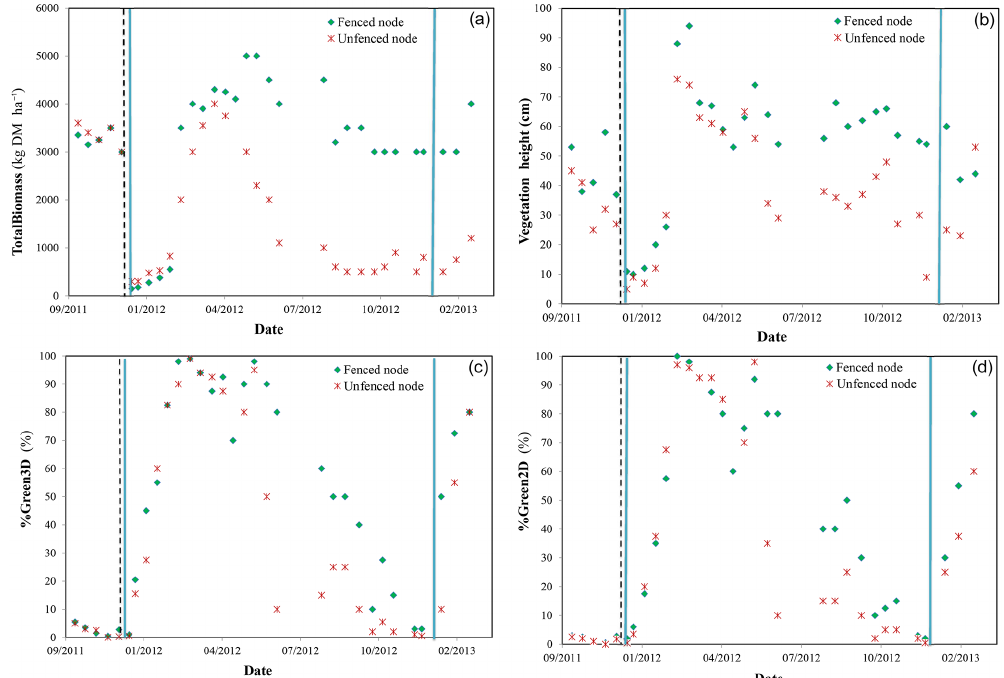
Figure 5. Field observation time series from the two nodes of (a) TotalBiomass, (b) VegetationHeight, (c) %Green3D, and (d) %Green2D. The black dashed line indicates the timing of the controlled burn and the blue lines the start of the wet